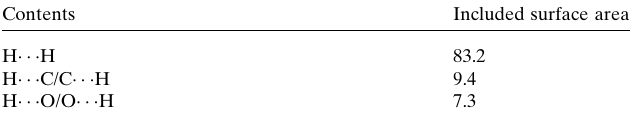
Table 2 Percentage contributions to the Hirshfeld surface of 1 .